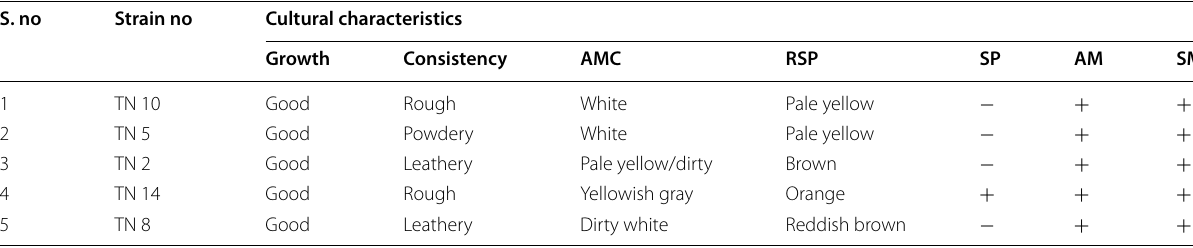
Table 2 Morphological characteristics of actinobacteria strains